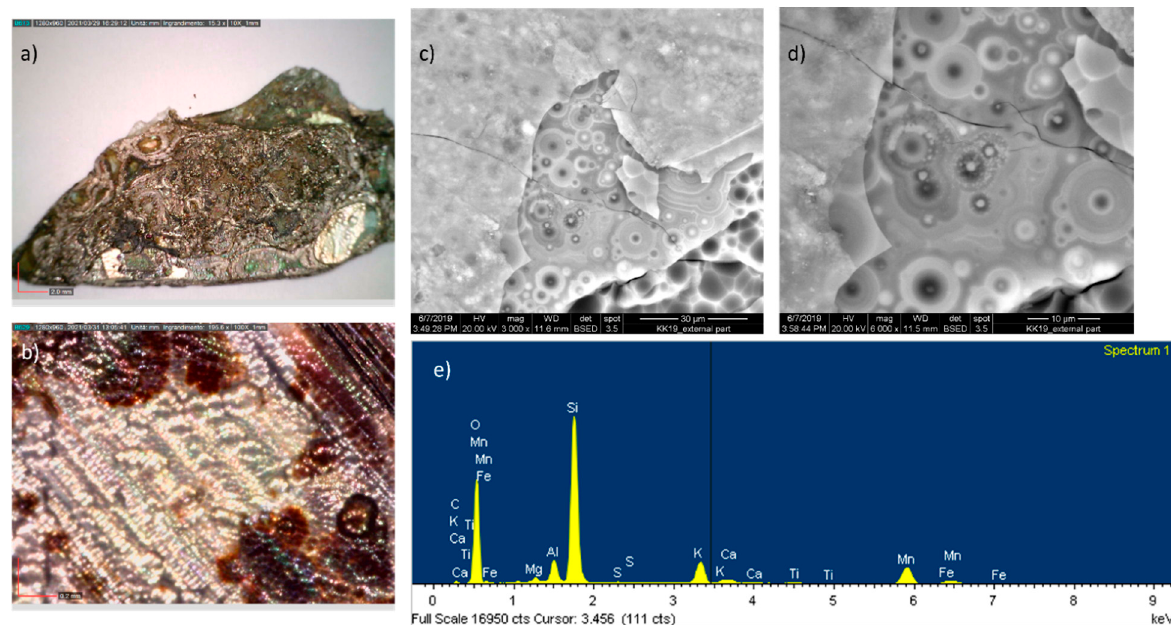
Figure 7. Blackening alteration: ( a ) OM documentation of fragment KK_d12; ( b ) detail of black stains under OM (100×); ( c , d ) BSE images of the lamellar structure, with details of concentric pits; ( e ) EDS spectrum acquired on the pits.